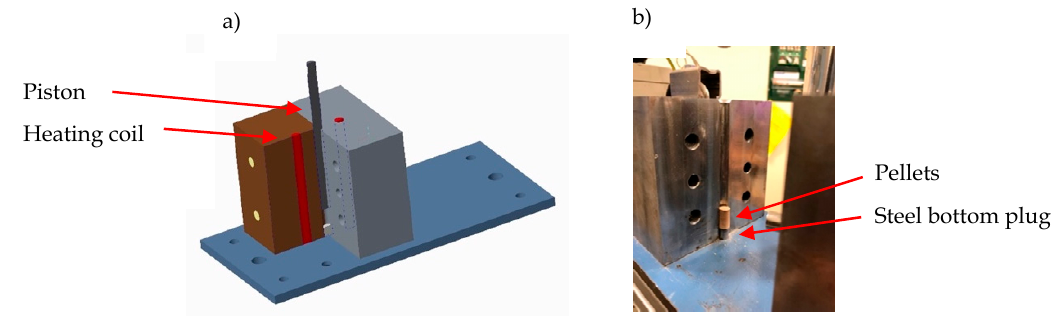
Figure 3. Test equipment; a) a cross section of the steel cube and b) a picture of the die disassembled